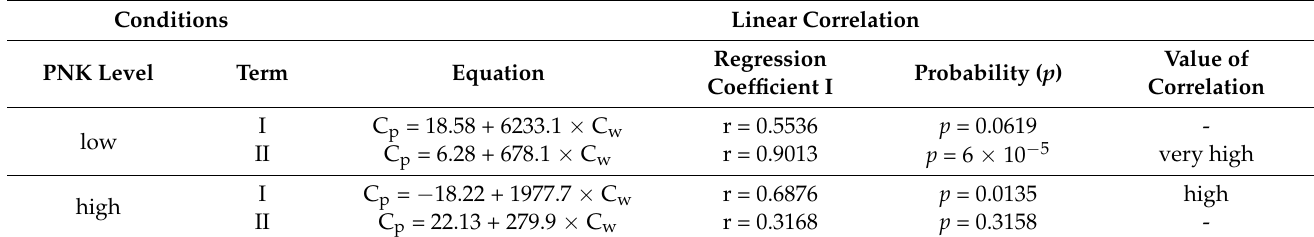
Table 3. The linear correlation between the cadmium concentration in water (µg Cd·dm −3 ) and the